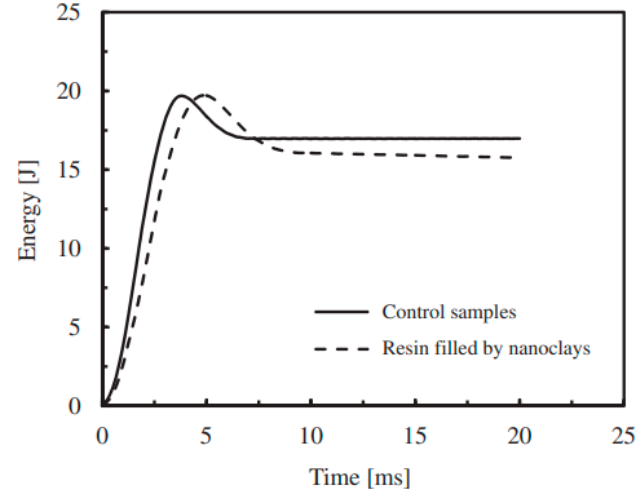
Figure 1. Energy versus time curves for sandwiches with epoxy resin and epoxy filled by nanoclays (impact energy of 20 J, sandwich composite made by fiber glass/epoxy skins and balsa wood core) [12].